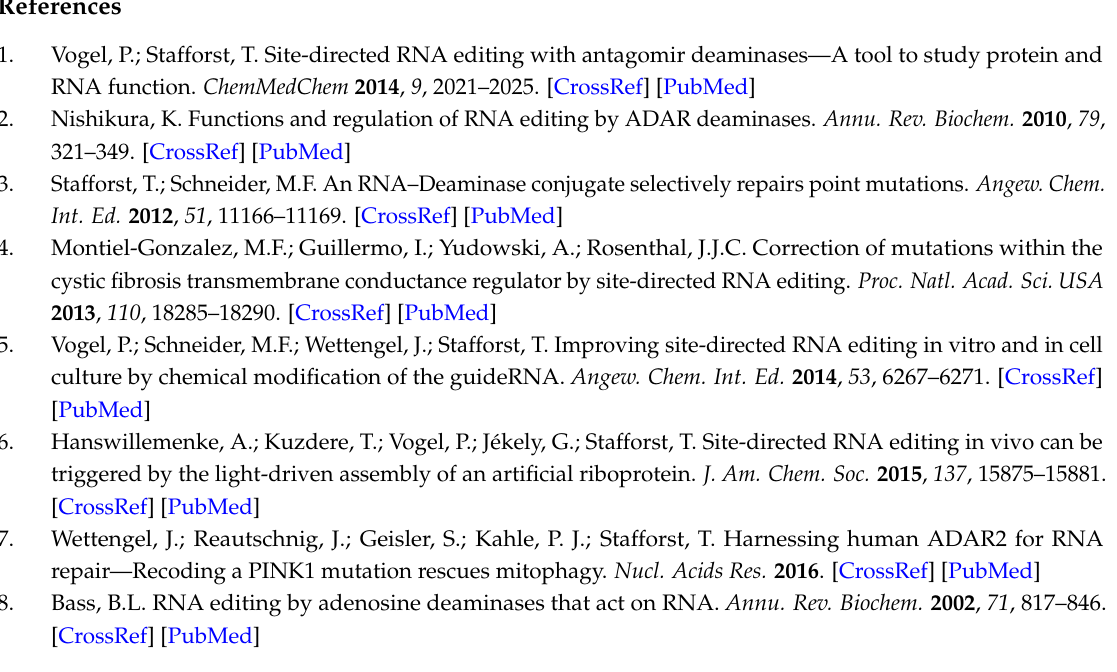
Figure S1: qPCR analysis of ADAR expression in engineered cells, Figure S2: Sanger sequencing trace of editing in ADAR1p110-expressing cells, Figure S3: Sanger sequencing trace of editing in ADAR1p150-expressing cells, Figure S4: Defining auto-editing hotspots in cellular editing; Figure S5: Fluorescence imaging data belonging to experiment shown in Figure